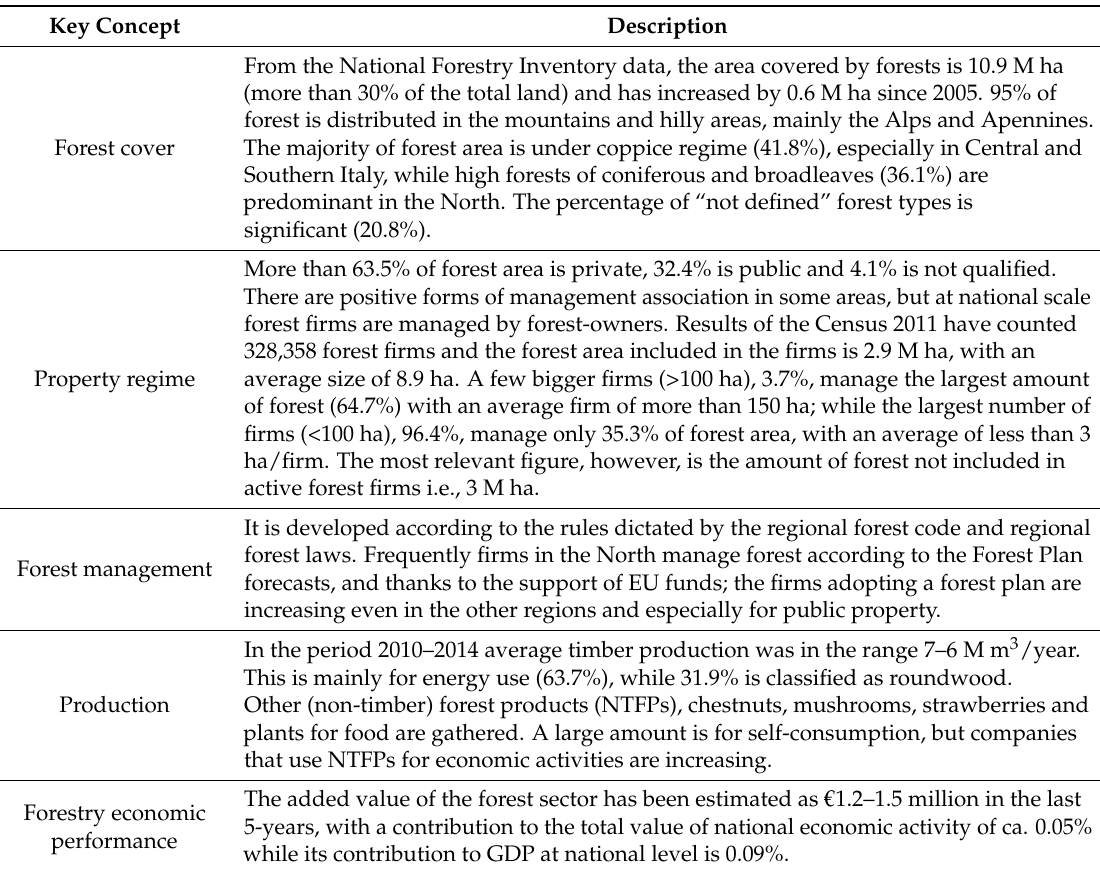
Table 1. Key concepts to understand the forest sector in